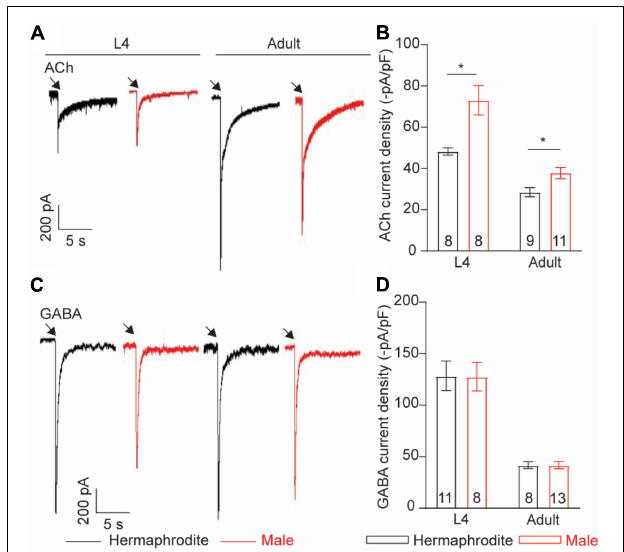
FIGURE 7 | Muscle cells exhibit sex-specific difference in ACh current intensity. Sample traces of body-wall muscle currents evoked by 1 mM ACh (A) and 1 mM GABA (C) in hermaphrodites and males at the larval stage L4 and adult stage. Bar graph of ACh-evoked currents (B) and GABA-evoked currents (D) in body-wall muscle cells. Sample sizes ( n numbers) are indicated in the bars of each graph. All data are represented as mean ± SEM (* p < 0.05, t